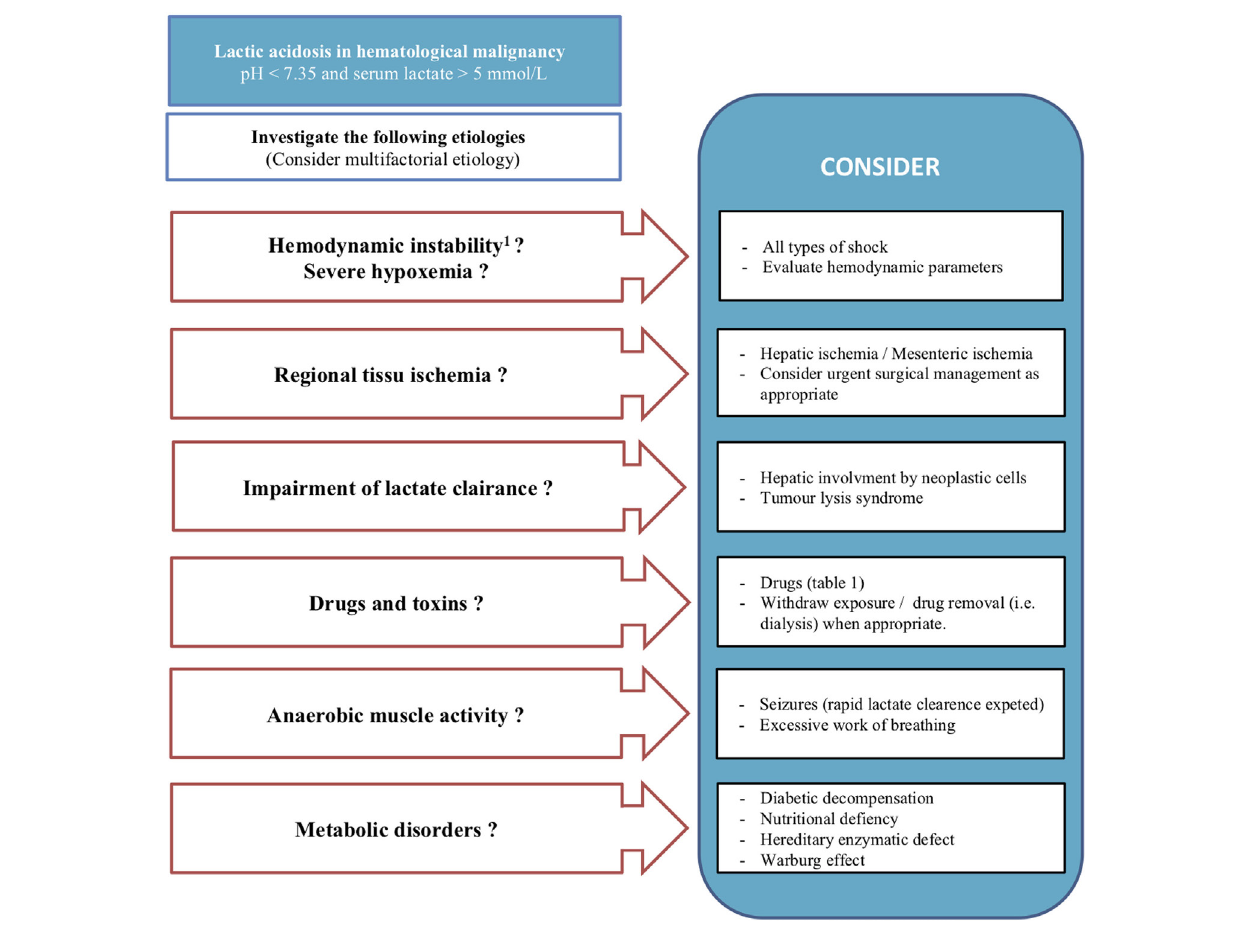
FIgURe 2 | LA in hematological malignancy: a checklist for clinicians. Mechanisms responsible for LA are not mutually exclusive and can co-exist in the same patient. 1 Mean arterial blood pressure < 65 mmHg or use of vasoactive agent, mottling, or prolonged capillary refilling test. LA, lactic